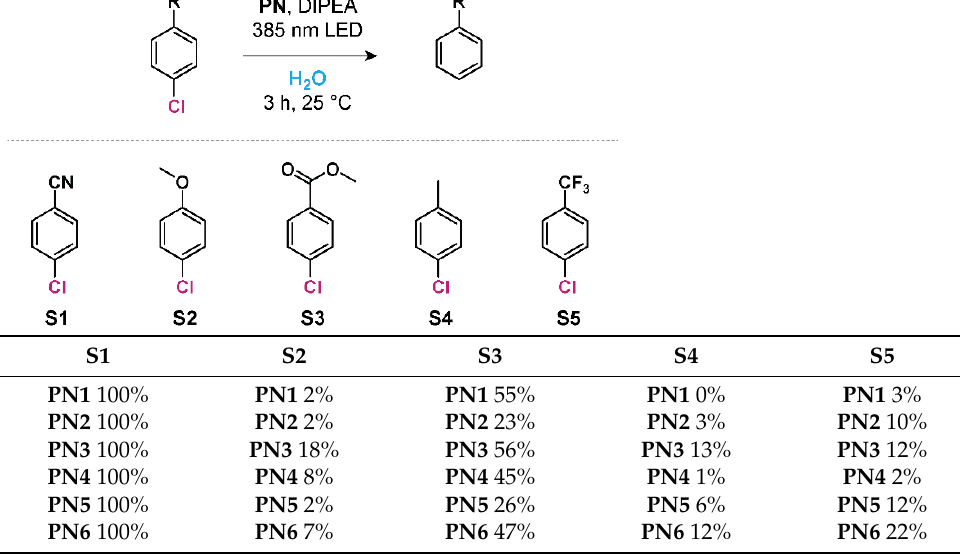
Molecules 2021 , 26 , x FOR PEER REVIEW